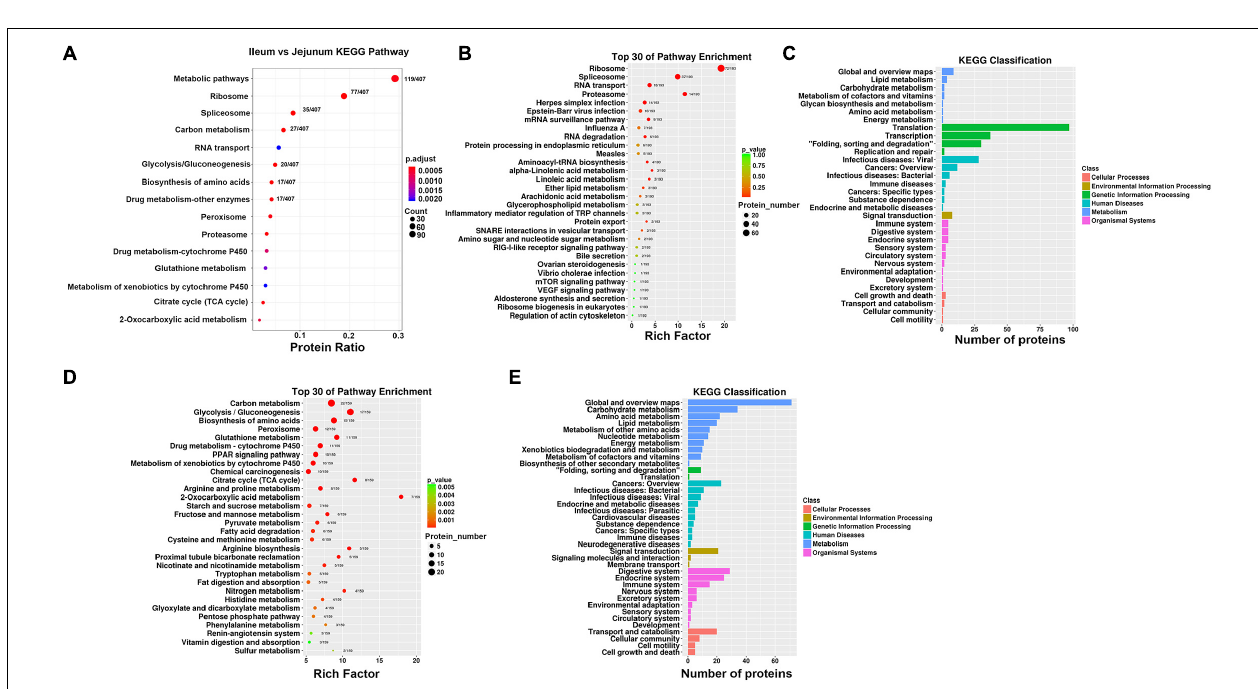
FIGURE 4 | Top 30 of GO enrichment in up/down regulated proteins in IEC-Exos. (A) GO enrichment analysis of up-regulated protein. (B) GO enrichment analysis of down-regulated protein.